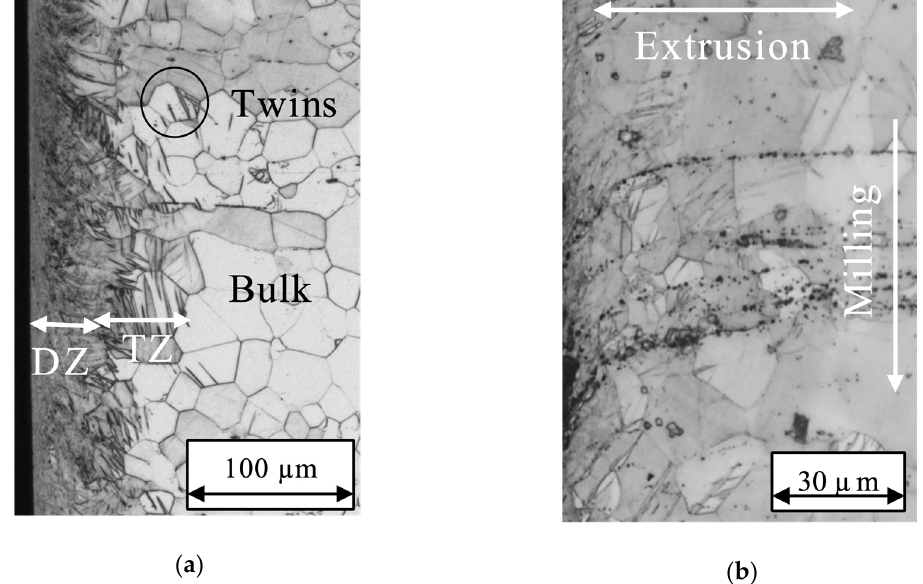
Figure 2. Micrographs of Mg-10Gd cross sections: ( a ) As received surface edge with deformed layer including a deformation zone (DZ) and twinning zone (TZ); ( b ) linear particle cluster are curved inside TZ.